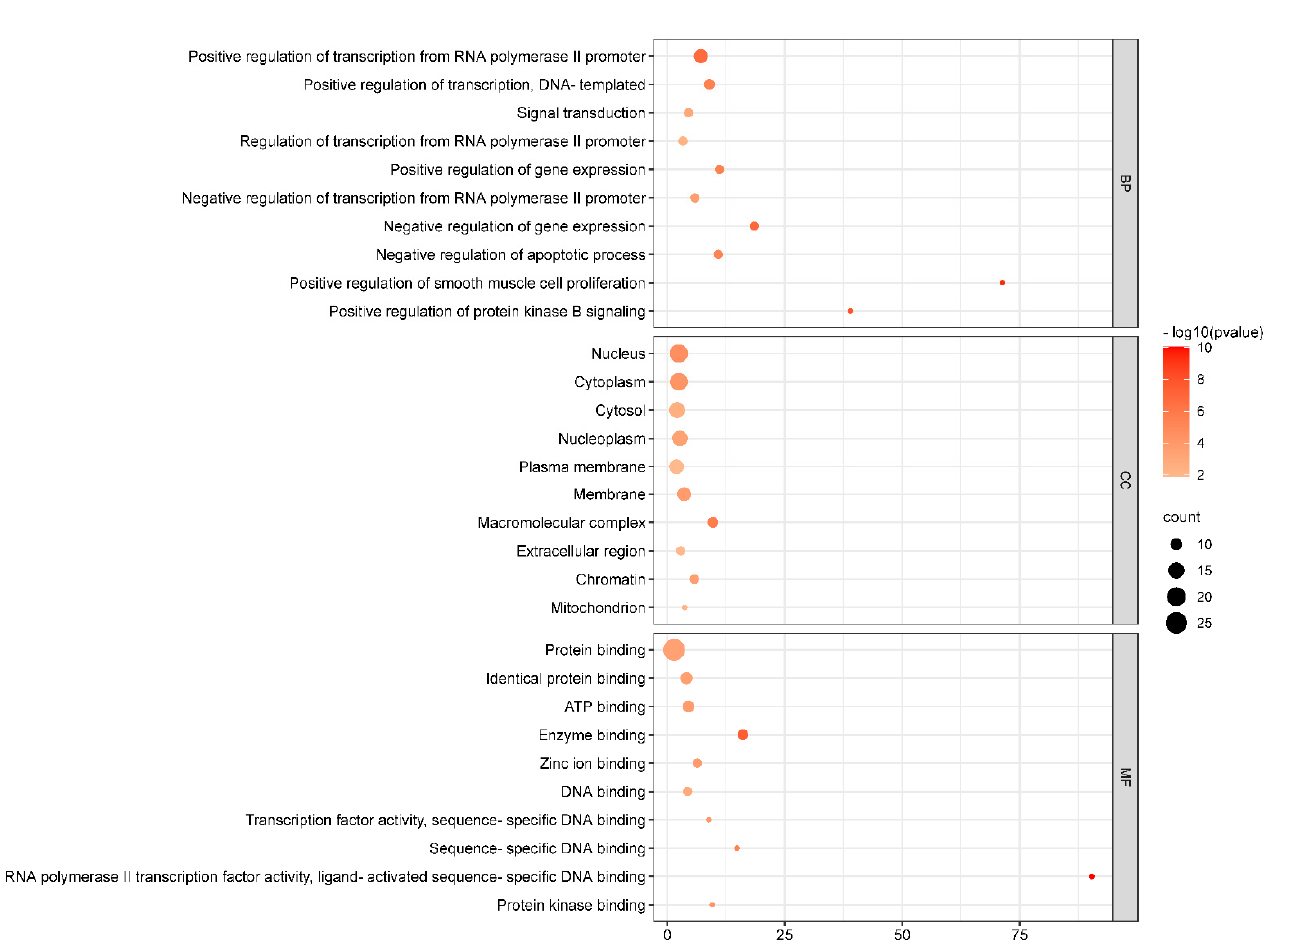
Figure 5. The GO enrichment analysis results of 27 major targets (top 10 were listed). The KEGG pathway enrichment analysis suggested that the major targets of HH on liver fibrosis were involved in pathways in cancer, chemical carcinogenesis-receptor activation, proteoglycans in cancer, the phosphoinositide 3-kinase (PI3K)/protein kinase (AKT) signaling pathway, prostate cancer, endocrine resistance, insulin resistance, lipid and atherosclerosis, epidermal growth factor receptor (EGFR) tyrosine kinase inhibitor resistance, and Th17 cell differentiation (Figure 6). The most target gene-enriched pathway, pathways in cancer, was visualized by the KEGG mapper to visualize the regulatory approaches involved in HH (Figure 7). Among these, the PI3K/AKT signaling pathway, mechanistic target of rapamycin (mTOR) signaling pathway, mitogen-activated protein kinase (MAPK) signaling pathway, peroxisome proliferator-activated receptor (PPAR) signaling pathway, and estrogen signaling pathway, which are involved in the pathogenesis of liver fibrosis, are regulated by HH through targeting the key